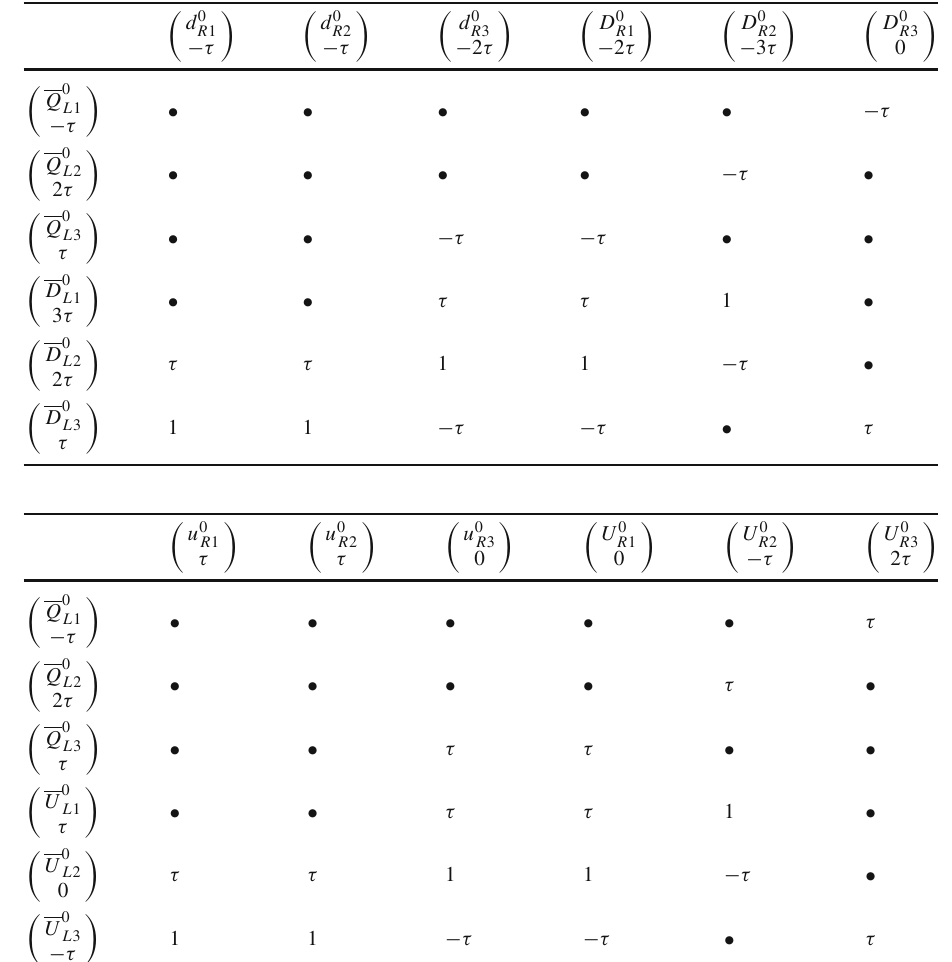
Table 2 Up sector, summary of transformation properties. In the forbidden terms we put a bullet sign. We denote by 1 the entries corresponding to allowed bare mass terms. The